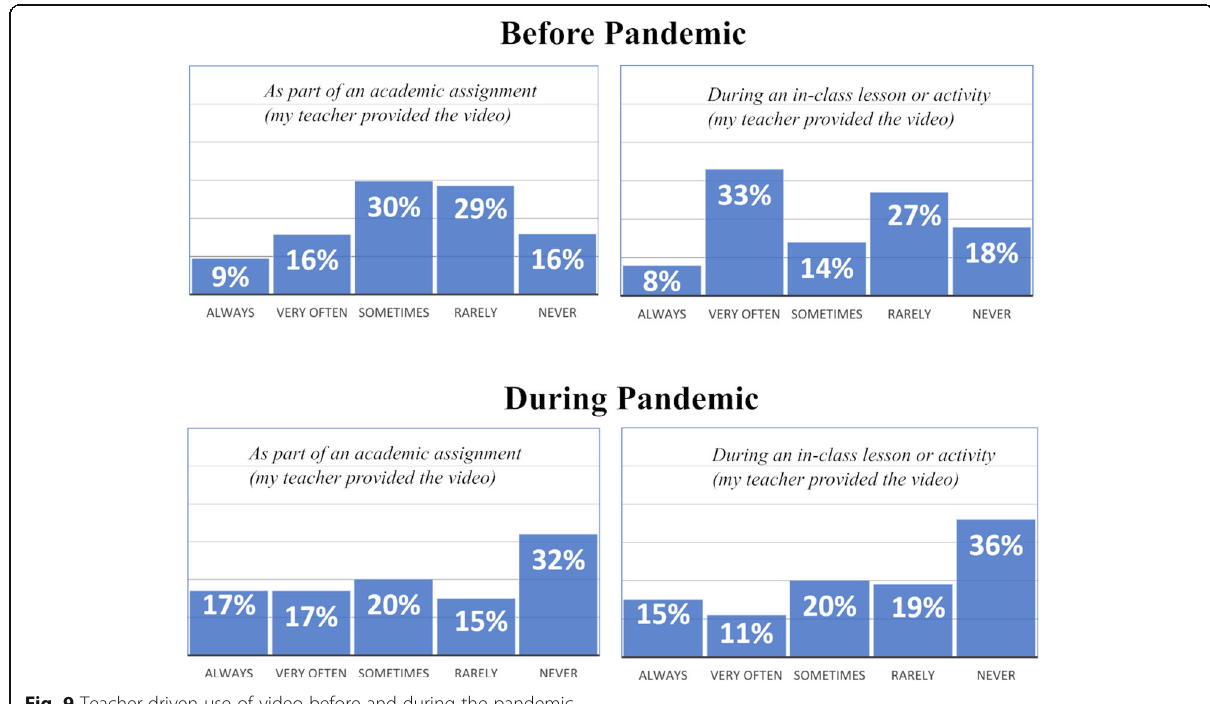
Fig. 9 Teacher-driven use of video before and during the